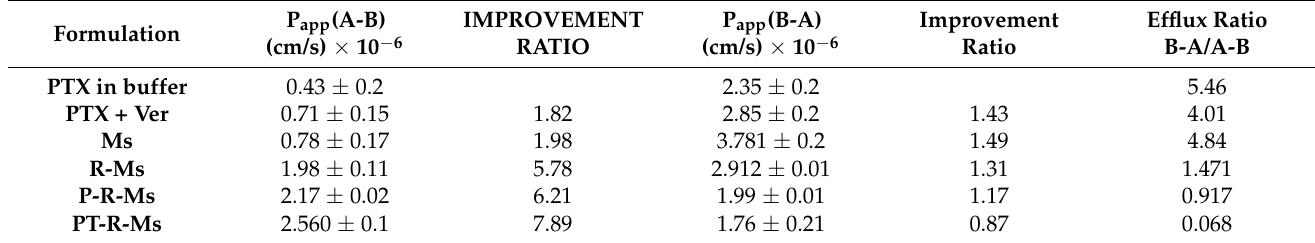
Figure 6. Ex vivo studies of PTX alone, PTX with verapamil, Ms, R-Ms, P-R-Ms, and PT-R-Ms across rat intestine: ( A ) Apical to basolateral permeation studies; ( B ) basolateral to apical permeation studies. PTX transport is expressed as cumulative transport. Results are given as mean ± SD ( n = 3) ( p < 0.05). Table 3. Ex vivo permeation and efflux ratio of PTX in buffer solution, PTX with verapamil (PTX-Ver), Ms, R-Ms, P-R-Ms, and PT-R-Ms. Values are given as mean ±SD ( n = 3).